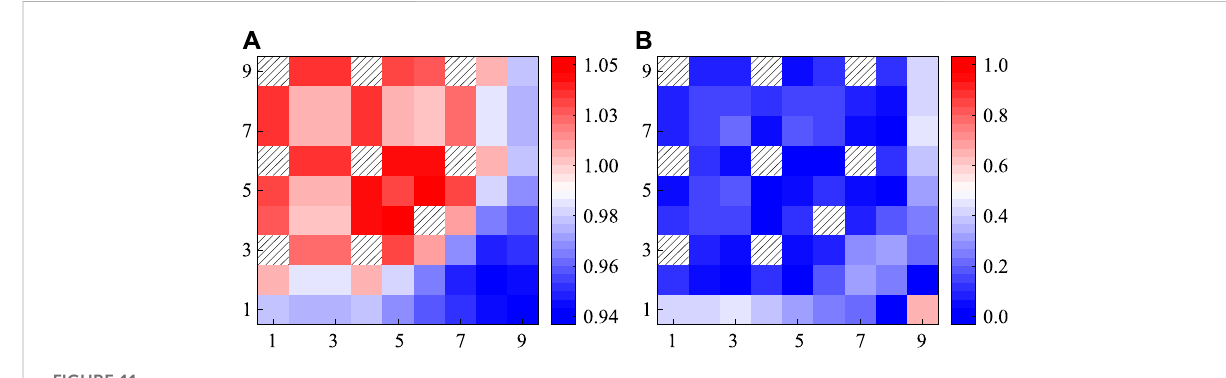
FIGURE 11 Calculation results of pin power of VERA 2C lattice: (A) referenced normalized pin power; (B) absolute value of relative deviation/%.